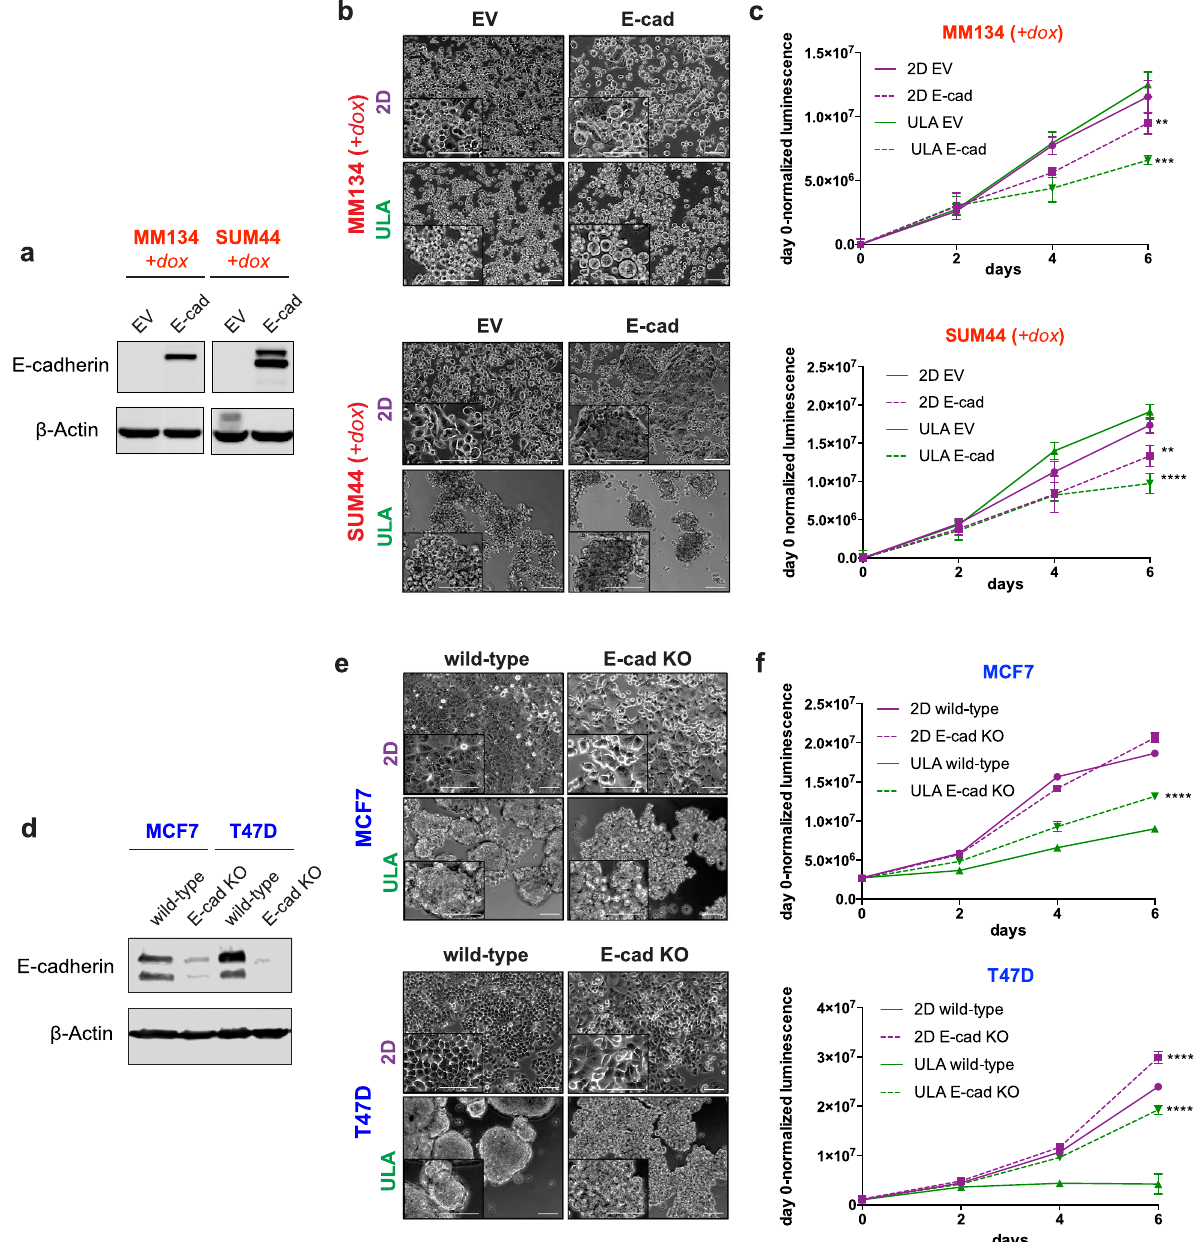
Figure 3. Effects of stable E-cadherin restoration in ILC and knockout in IDC cell lines on cell morphology and viability in 2D and ULA culture. ( a – f ) Immunoblotting for E-cadherin ( a , d ), morphology ( b , e ) and growth ( c , f ) in 2D (purple) or ULA (green) culture in the ( a – c ) ILC (red) cell lines MM134 (left; top) and SUM44 (right; bottom) stably transfected with a doxycycline (dox)-inducible empty or E-cadherin (E-cad) overexpression vector and ( d – f ) IDC (blue) cell lines MCF7 (left; top) and T47D (right; bottom) with CRISPR-mediated stable knockout (KO) of E-cadherin (E-cad). β-Actin was used as a loading control. Scale bar: 100 μm. Graphs show representative data from two–three experiments (n = 6). p-values are from two-way ANOVA comparison of ( c ) empty vector and E-cad or ( f ) wild-type and E-cad KO in 2D and ULA culture separately. **p ≤ 0.01; ***p ≤ 0.001; ****p ≤